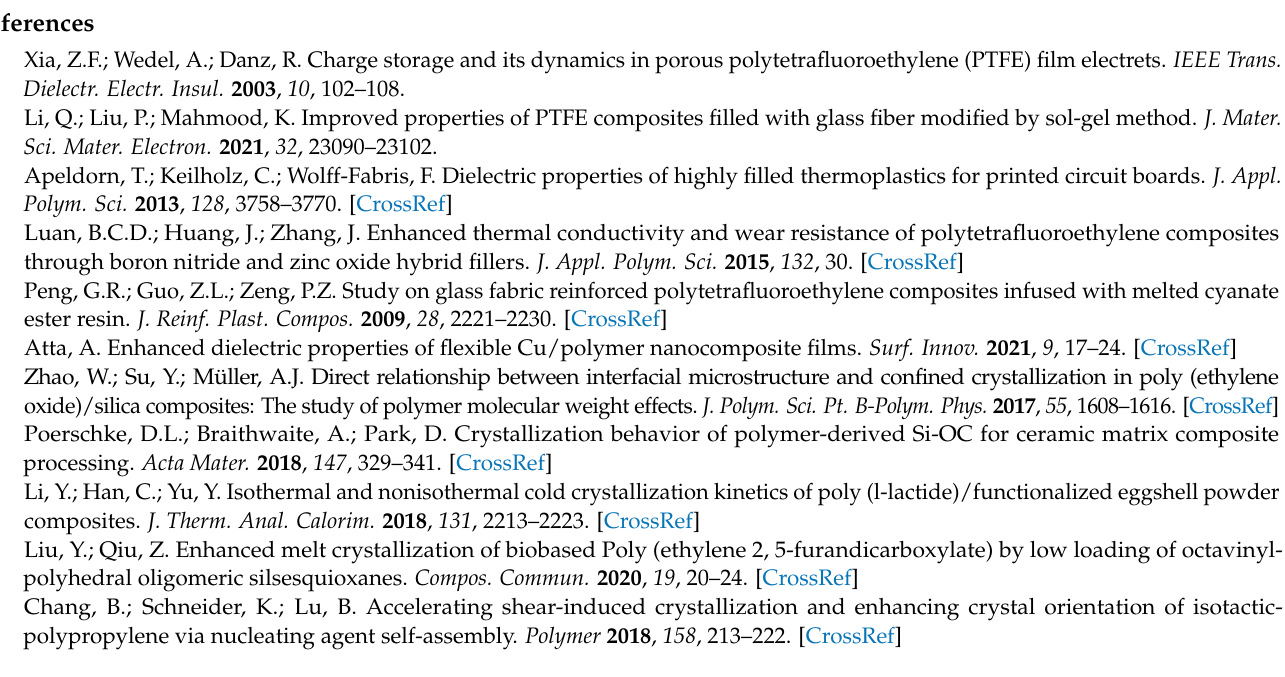
temperature distribution of Figure S4d; (r) local detail of Figure S4q, Figure S5: Morphology of PTFE crystal evolution with different aniso-tropic strengths, ε . (a–d) ε = 0.01, τ = 40, 120, 200, 280; 200, 280, Figure S6: Morphology of PTFE crystal evolution with different interface thickness